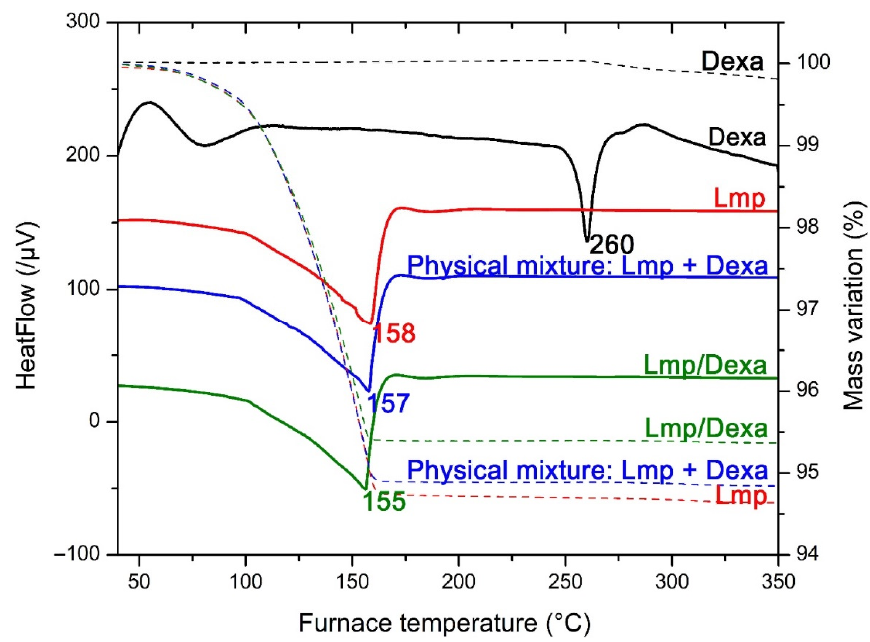
Figure 3. Overlapped DSC and TG thermograms of pure Dexa, Lmp, the physical mixture of Lmp+Dexa, and Lmp/Dexa.